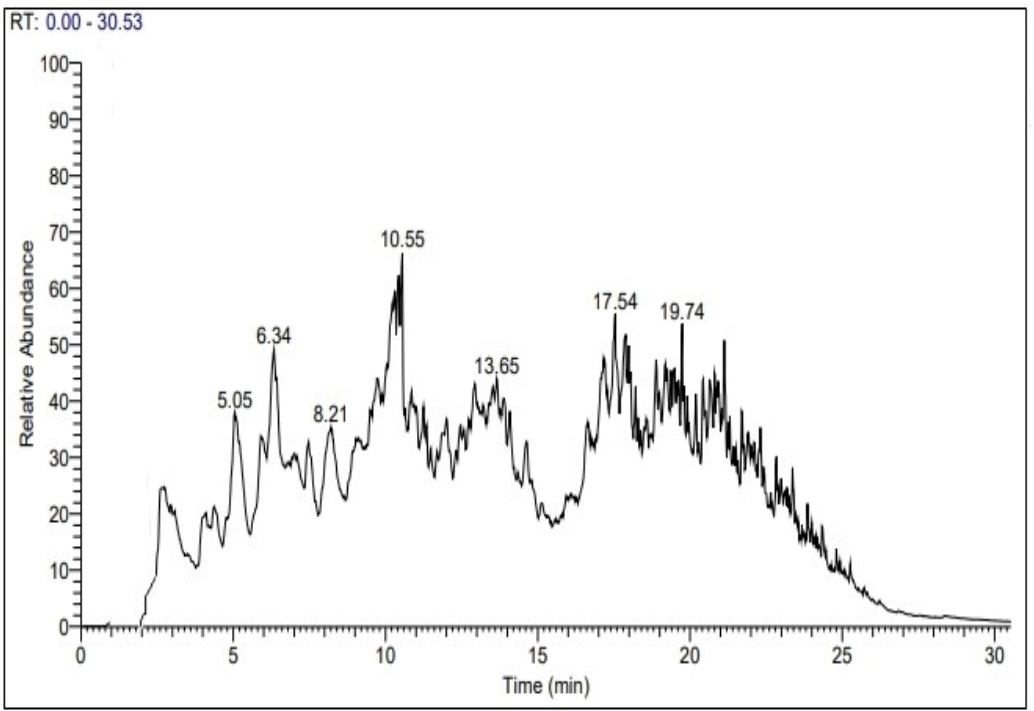
Figure 4. ( a ) Effect of temperature on pyrolysis products; ( b ) effect of time on product yield.